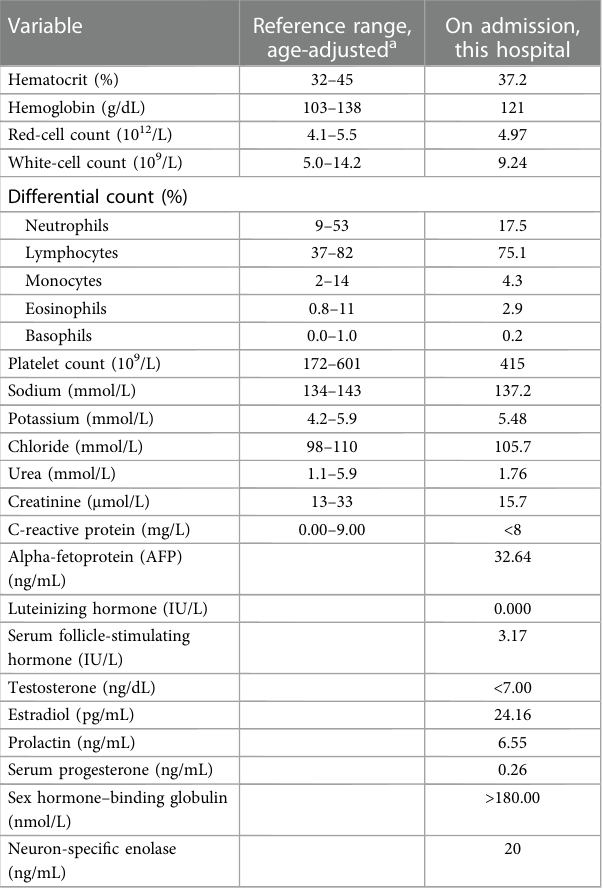
TABLE 1 Laboratory